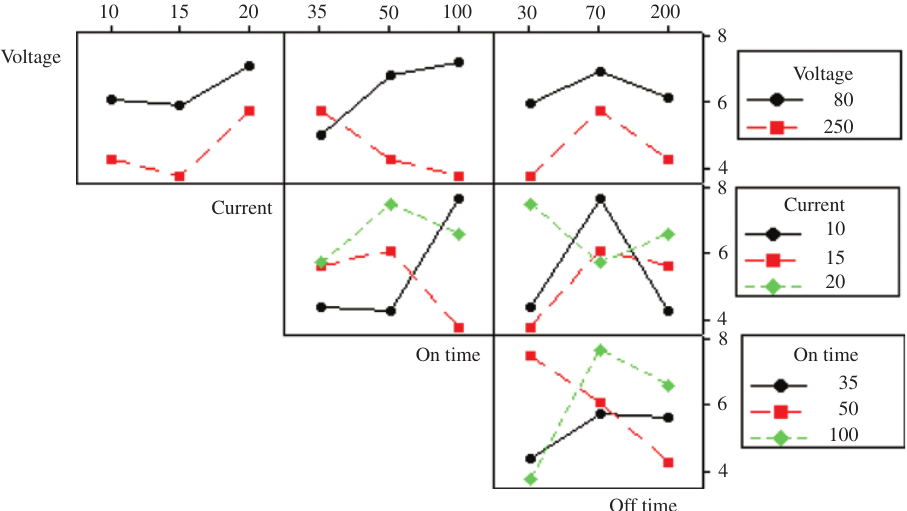
Figure 8: Interaction plot for the process parameters on MRR in the machining of Al/5%Al